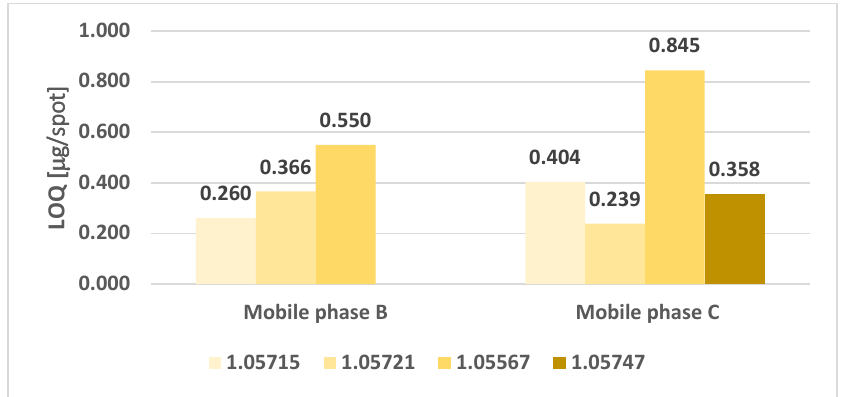
Figure 7. Mean values of the limit of quantification of sertraline, obtained by adsorption thin-layer chromatography, where the mobile phases were as follows: A—chloroform + methanol + ammonia, 9:1:0.4 ( v/v/v ); B—chloroform + methanol + glacial acetic acid, 5:4:1 ( v/v/v ); C—acetone + toluene +